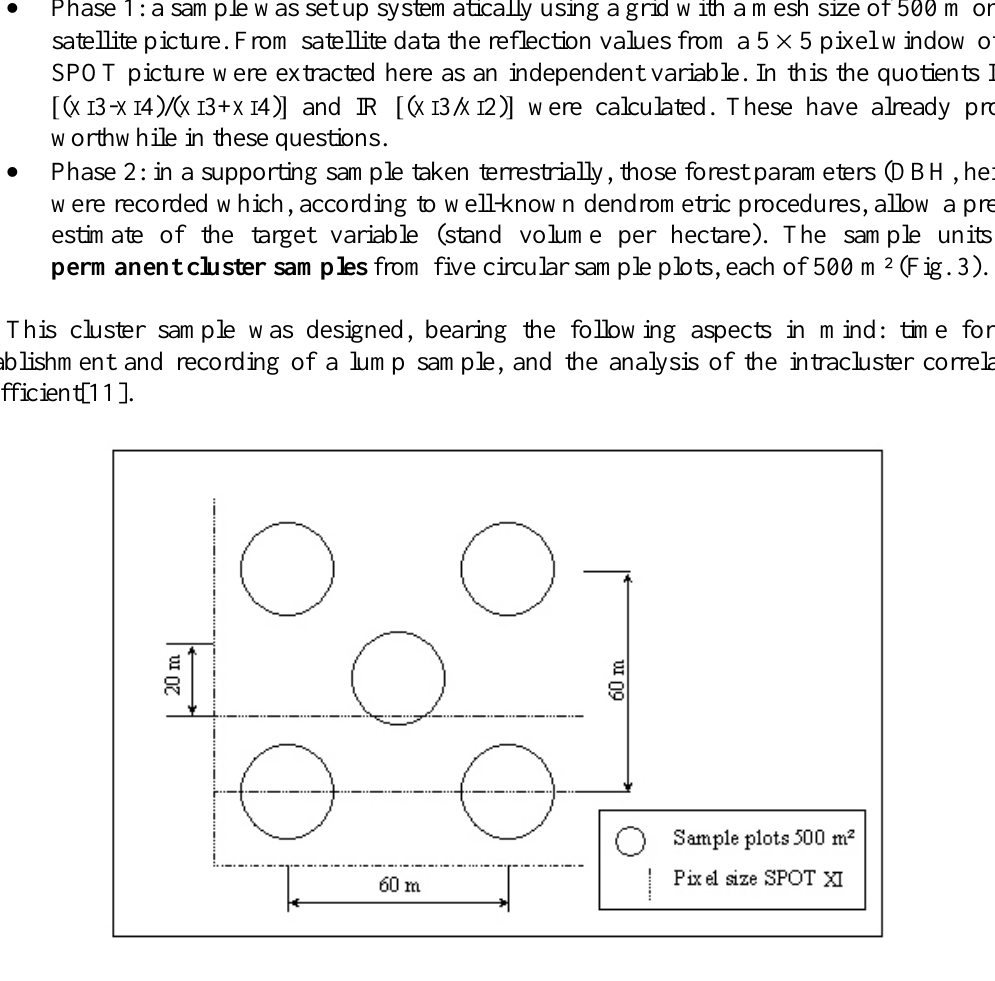
FIGURE 3 . Cluster samples consisting of five circular plots of 500 m² each and their relation to the spatial resolution of the SPOT